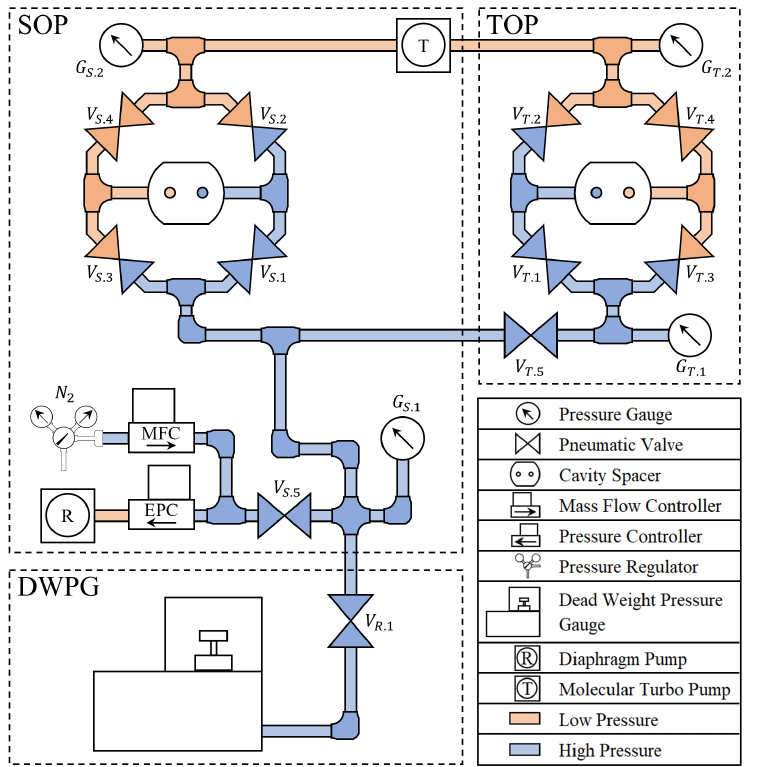
Figure 3. Schematic view of the gas delivery system. The components are described by the legend in the lower right corner. The setup is divided into three sub-systems, viz., the SOP, the TOP, and the DWPG. The SOP, presented in the upper left corner, regulates and controls the gas filling unit, consisting of the MFC and EPC. It also controls the primary fill valve, V S ,5 . The valves V S .1 − 4 , which control the filling and evacuation of the cavities, are opened or closed in a given sequence. This subsystem also comprises two pressure gauges: G S .1 , which monitors the high pressure side; and G S .2 , which measures the residual pressure on the low pressure side. The TOP, which is displayed in the upper right corner, applies the same logic as the SOP system to its valves ( V T .1 − 4 ) and gauges ( G T .1 − 2 ). This subsystem can additionally be connected to or disconnected from the gas delivery system by use of valve V T .5 . Finally, the DWPG is presented in the lower left corner. This is connected or disconnected to the rest of the system by the valve V R .1 . In this presentation, the systems are displayed with the filling/connecting valves, V S .5 , V S .1 , V T .5 , V T .1 , and V R .1 open. This implies that the measurement cavities are filled by the pressure set by the DWPG (represented by the blue gas lines). In addition, the valves V S .4 and V T .4 are open to allow for an evacuation of the reference cavities (represented by the red gas lines). The measurement cycle is followed by an evacuation state in which the valves V S .1 and V T .1 are closed and V S .2 and V T .2 are opened, which evacuates all